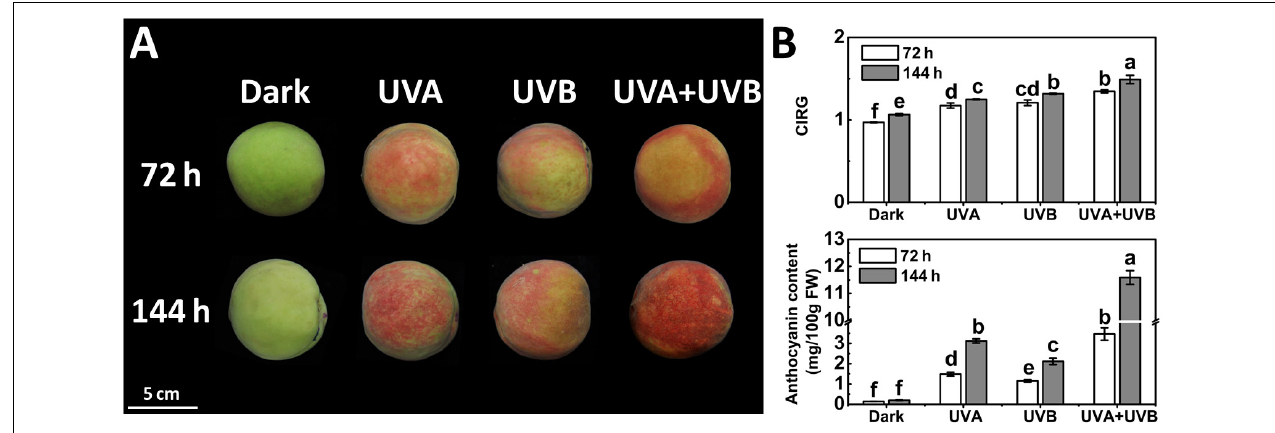
FIGURE 1 | Coloration (A) and the color index of red grapes (CIRG) values and anthocyanin content (B) in the peach peel after continuous UV irradiation or kept in dark. UVA, 1,000 µ w/cm 2 ; UVB, 58 µ w/cm 2 . Scale bar indicated 5 cm. Data were presented as means ( ± SE) from three independent biological replicates. Values labeled with different letters indicated a significant difference at P <